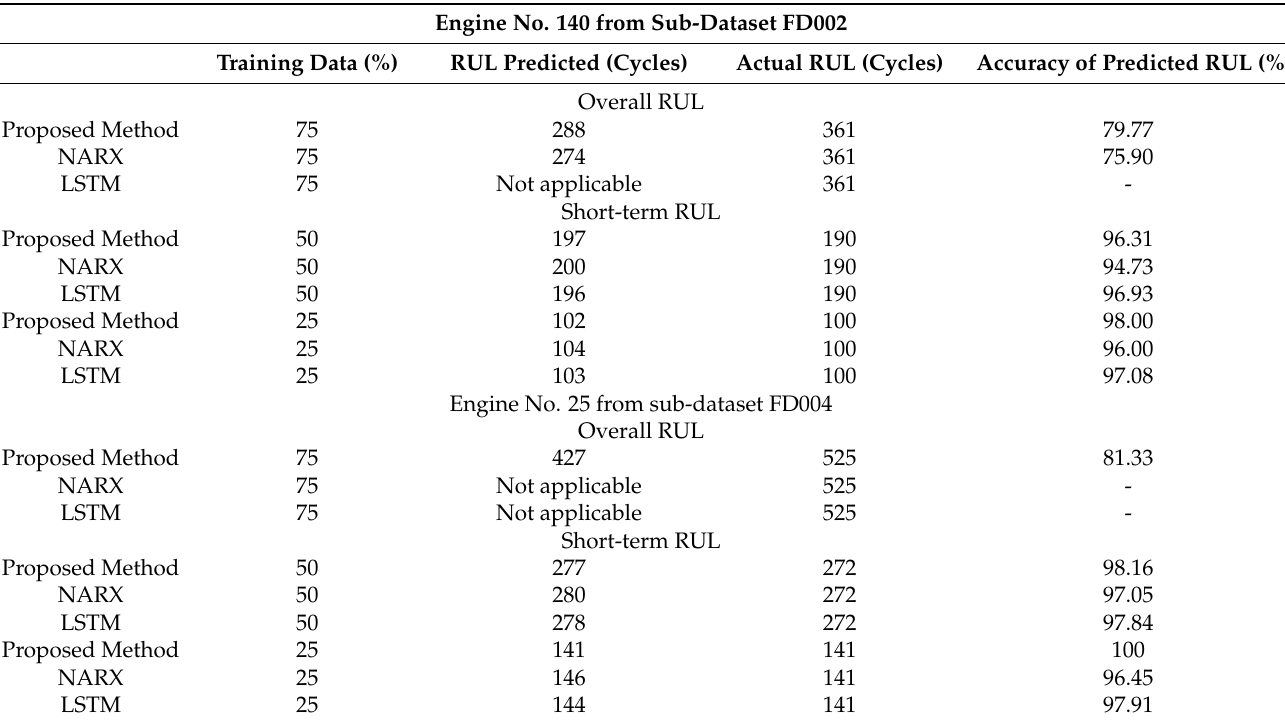
Table 3. The actual RULs, predicted RULs by the LSTM, NARX and the developed model, and the accuracy of the obtained predicted RULs for turbofan jet